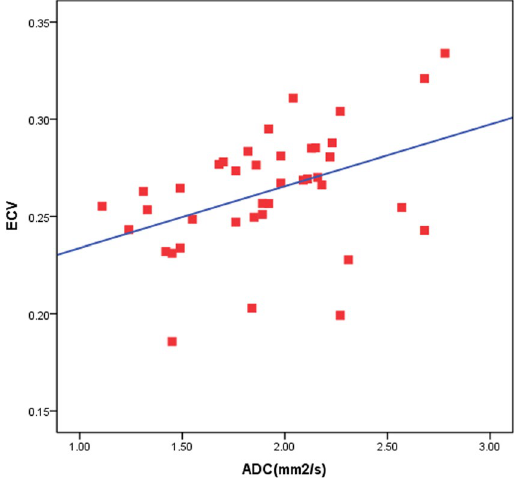
Figure 4. ( a ) ECV versus ADC. Pearson’s correlation shows a linear association between ADC and ECV (R = 0.1, p <